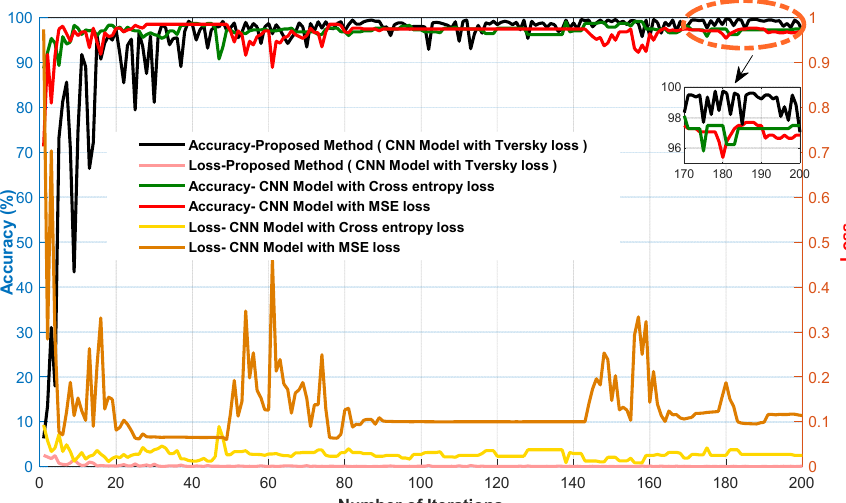
Figure 11. The accuracy and error plots of the proposed customized CNN model with the Tversky loss function (i.e., proposed method) compared with the CNN model with the cross-entropy and MSE loss functions.